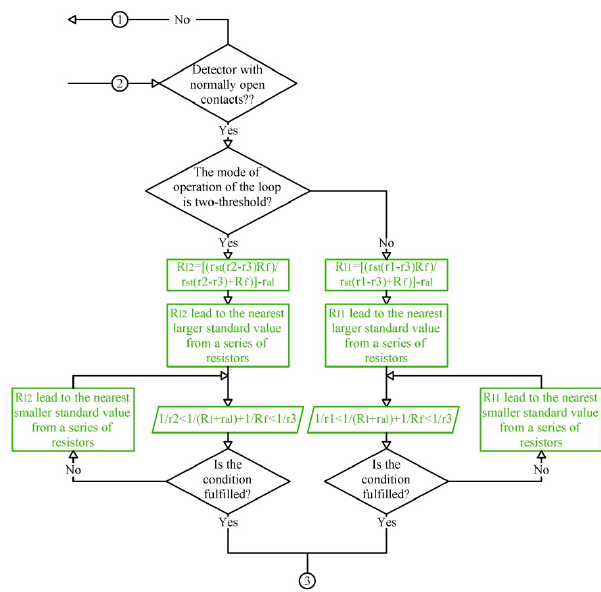
Figure 16. An algorithm for calculation of external components of FAL